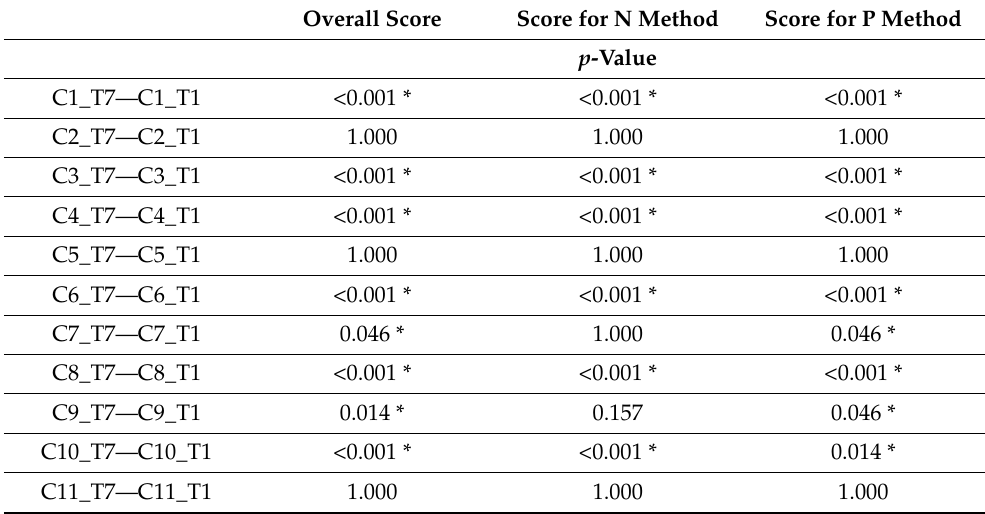
Table 3. Wilcoxon Signed Ranks test results ( p -values) after comparing the baseline scores (T1) and the scores after 7 years (T7) for each FDI criterion.